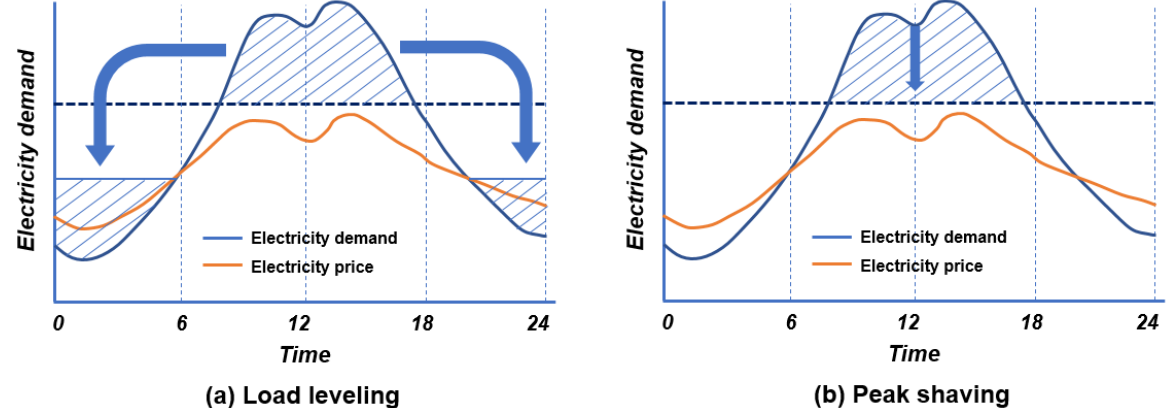
Figure 5. Load leveling and peak shaving: ( a ) load leveling: overall consumption remains the same during load leveling, ( b ) peak shaving: overall consumption is reduced during peak shaving.